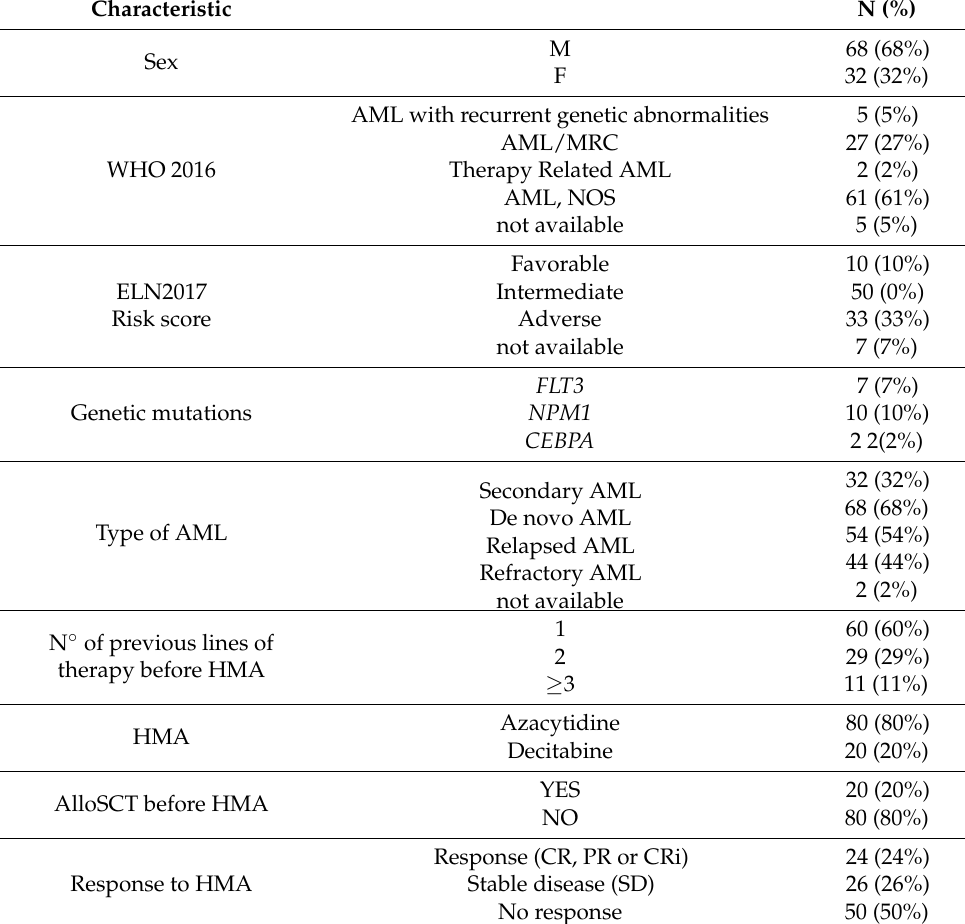
Table 1. Characteristics of study population (100 patients, median age 64.3 years (range 25.2–82.8)).